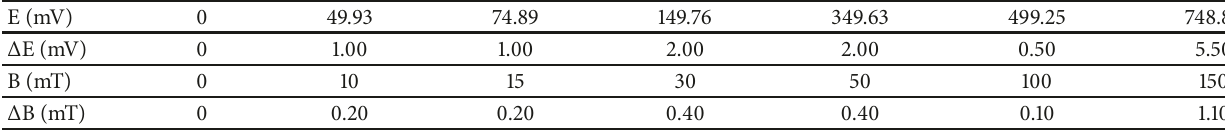
Table 1: Effective values of the magnetic field.